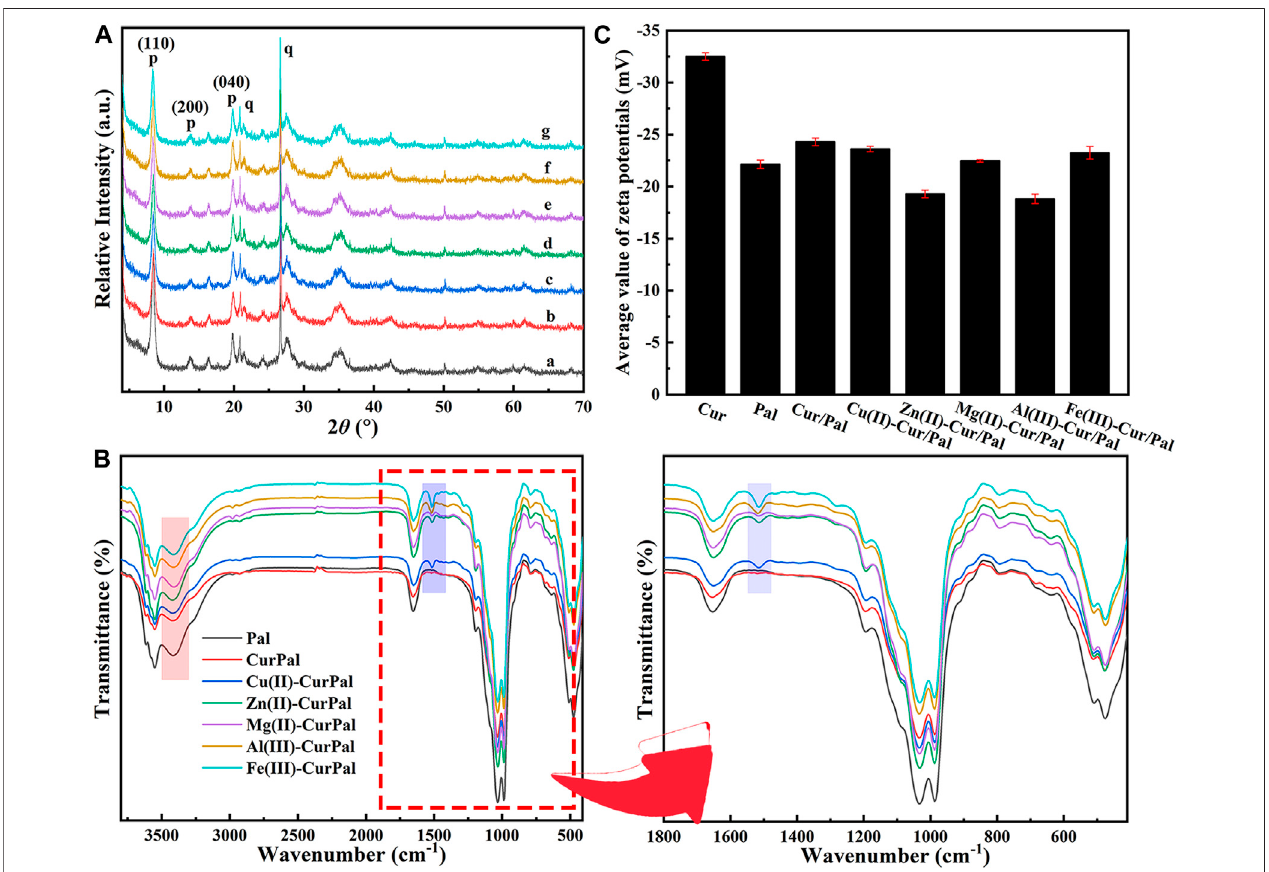
FIGURE 2 | (A) XRD patterns, (B) FTIR spectra and local magni fi cation, and (C) Zeta potential of Pal, Cur/Pal and metal ions-Cur/Pal hybrid materials.